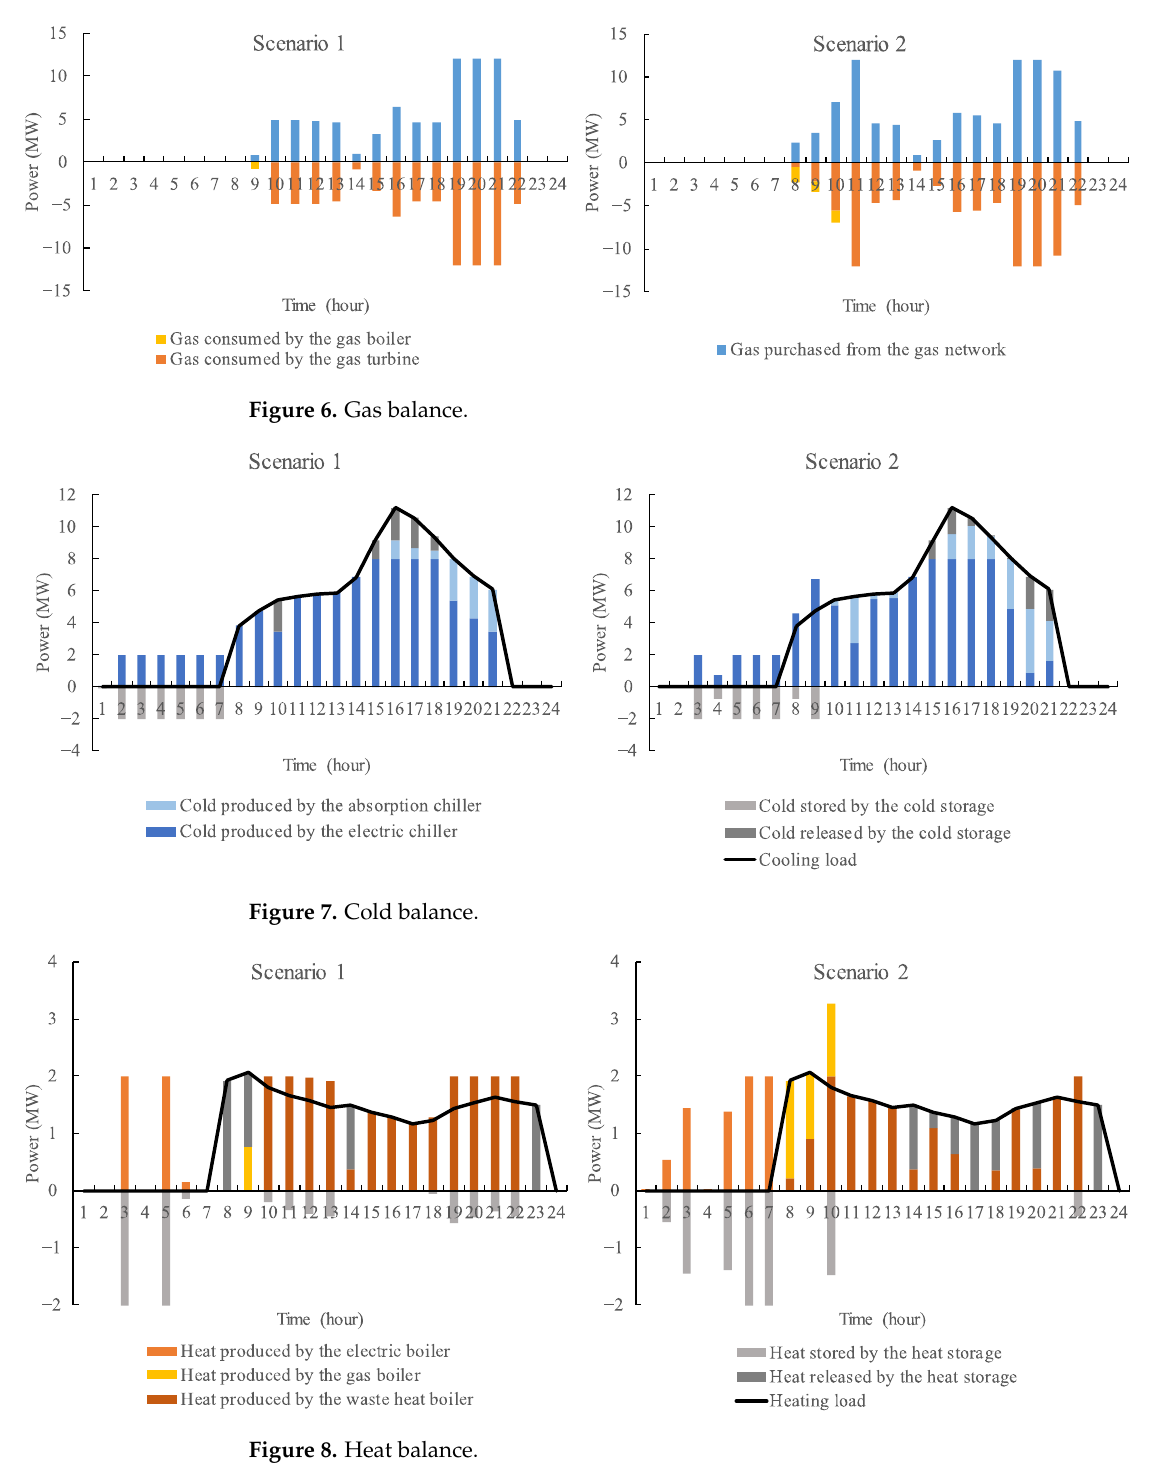
Figure 5. Power balance.